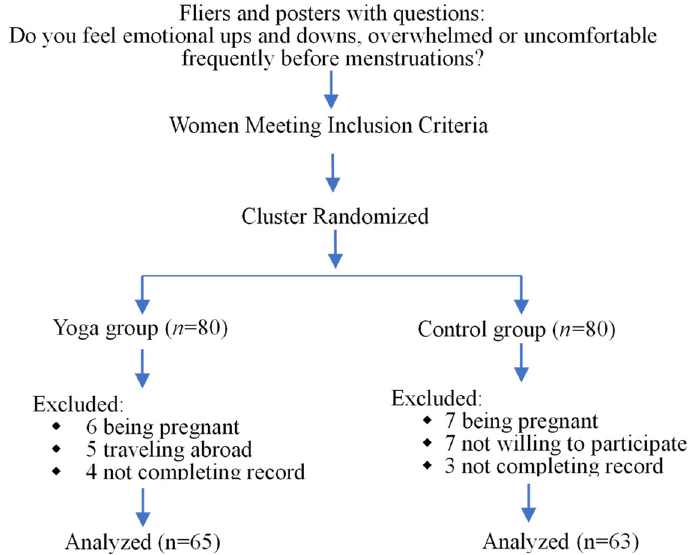
Figure 1. Flow diagram of participant enrollment. Table 1. Characteristics of the participants in both